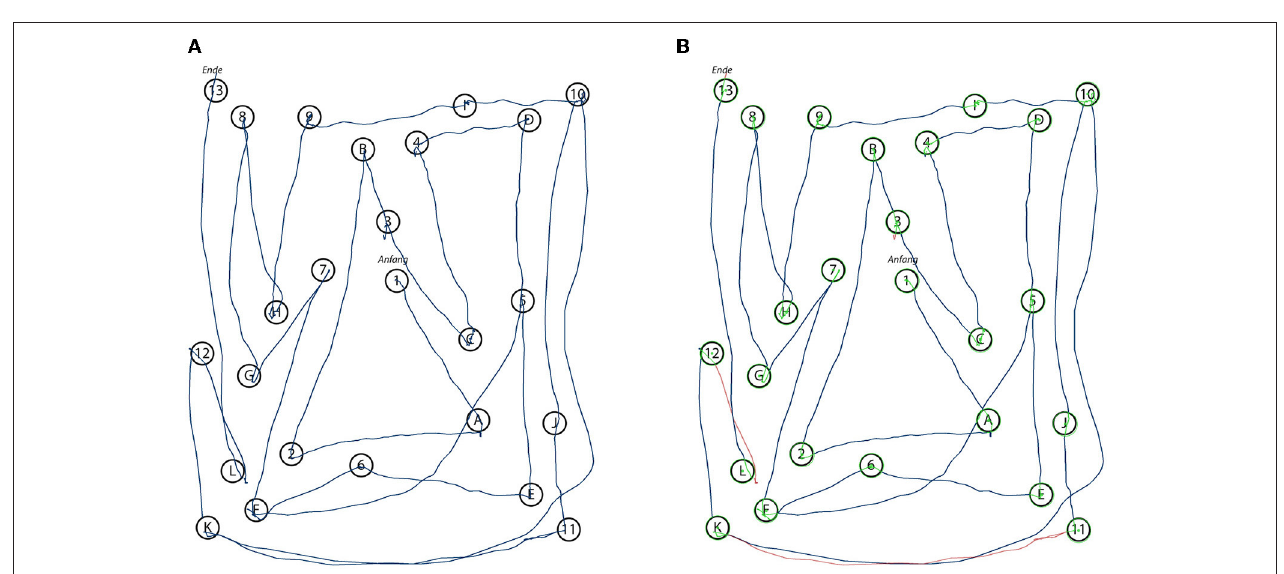
FIGURE 4 | Renderings of the original input (A) as recorded by the digital pen during the data collection with a subject performing the TMT-B. The automated system analyzes the input and annotates the stroke data with the information relevant for the algorithm’s final scoring decision (B) . Green dots indicate the center points of the circles and green stroke parts indicate that a circle has been successfully hit by a stroke, while red strokes could not be identified as connecting two